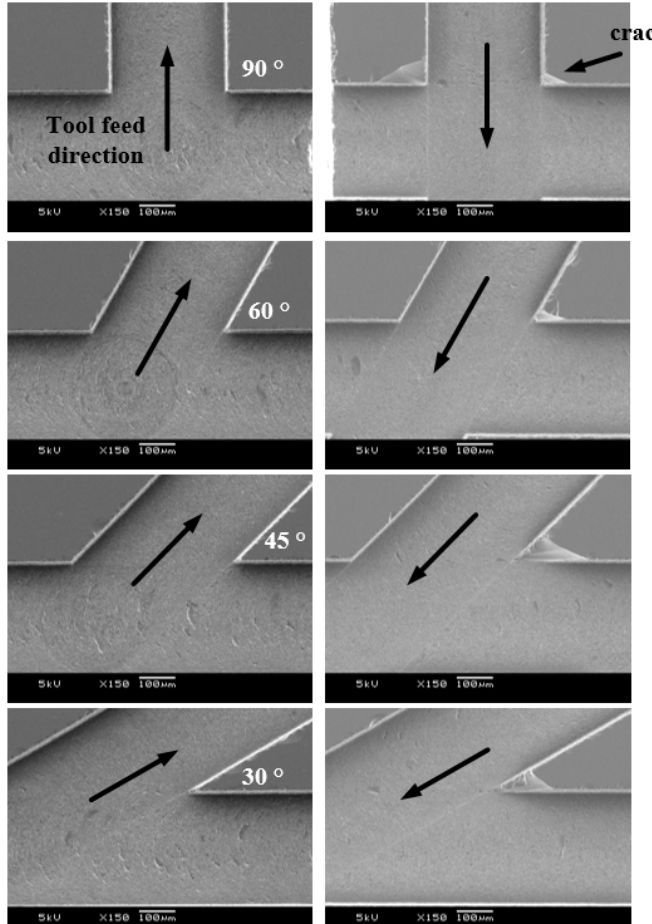
Figure 12. The SEM images of branched channels with different angles and tool feed directions (feed rate: 100 µm/s; depth of cut: 5 µm; 50,000 rpm; channel depth: 100 µm).